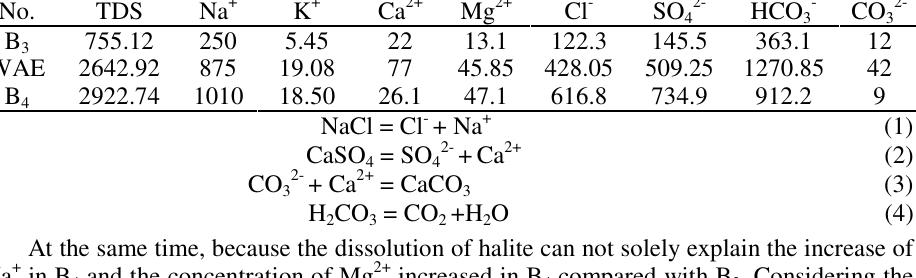
Table 2 Comparison of the water chemistry of B